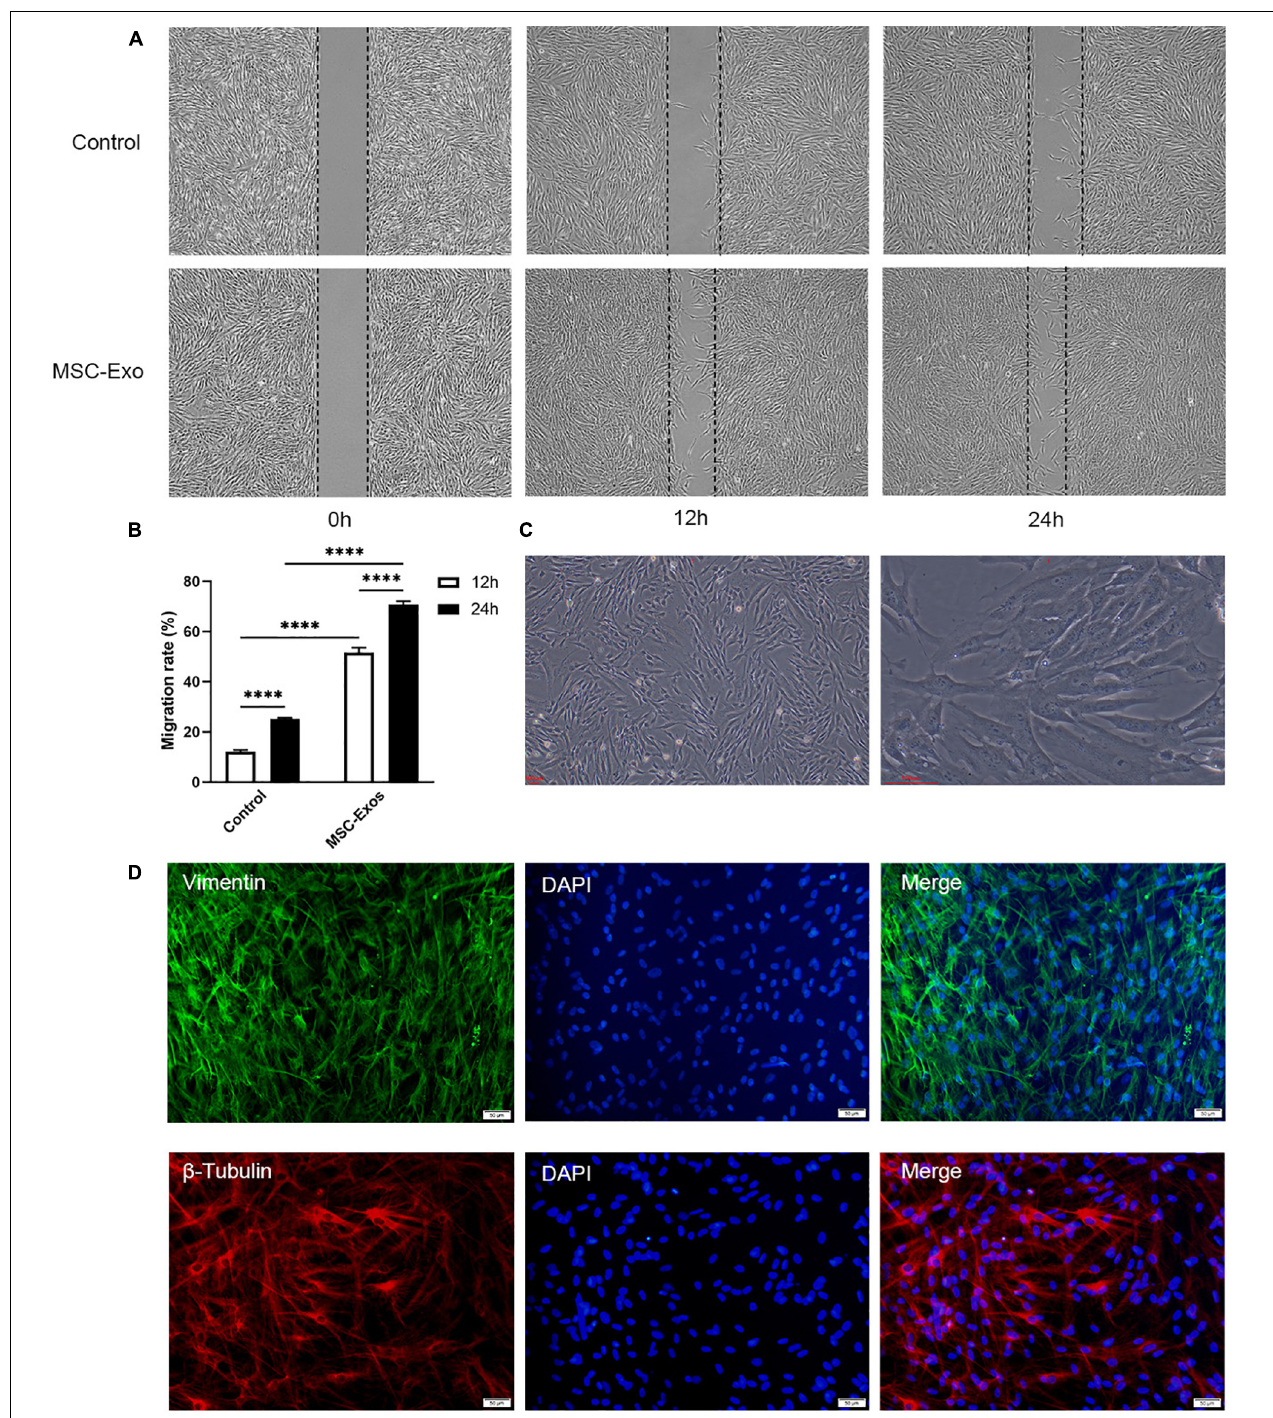
FIGURE 3 | UC-MSC-Exo promote the growth of skin fibroblasts. (A) Scratch wound assay for HDFs treated with UC-MSC-Exo in three time points. (B) Statistical analysis of migration rates. **** p < 0.0001. Error bars indicate SDs of triplicate samples in a single representative experiment. SD, standard deviation. (C) The morphology of HDFs. Scale bar = 100 µ m. (D) The immunofluorescence images of vimentin and β -tubulin. HDFs were immunolabeled for vimentin (green) and β -tubulin (red), and nucleic acid was signed with DAPI (blue). Scale bar = 50 µ m.